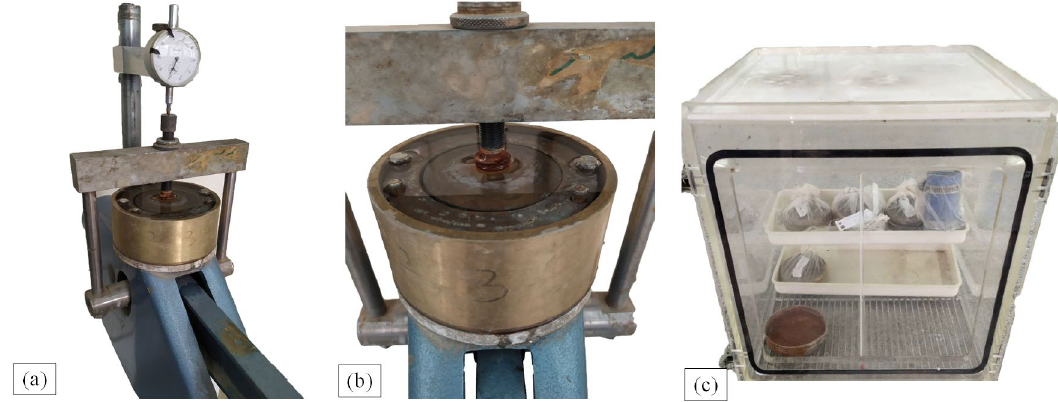
Figure 4. One-dimensional compression test; ( a ) under the loading application, ( b ) curing samples at saturated conditions, ( c ) curing sample at optimum moisture content (OMC)